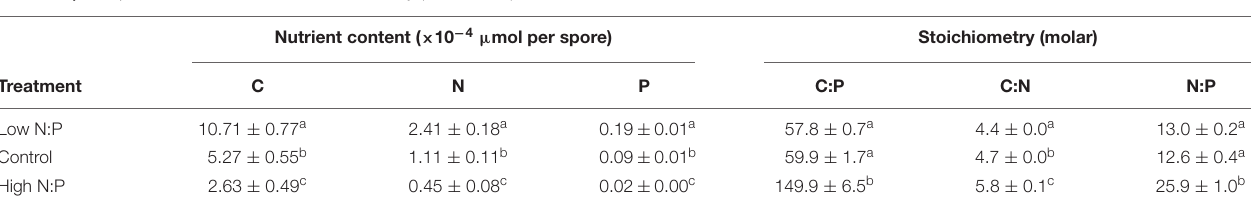
FIGURE 2 | N:P ratios of uninfected host (A) and zoospores (B) , and elemental content of the host (C) and zoospores (D) in the control (circle), low N:P (triangle) and high N:P (square) treatments. Symbols represent mean ± standard error ( n = 4). In (C,D) black, gray, and white symbols indicate carbon, nitrogen and phosphorus content, respectively. Solid lines indicate significant correlations ( P < 0.05). TABLE 3 | Zoospore nutrient content and stoichiometry (mean ±